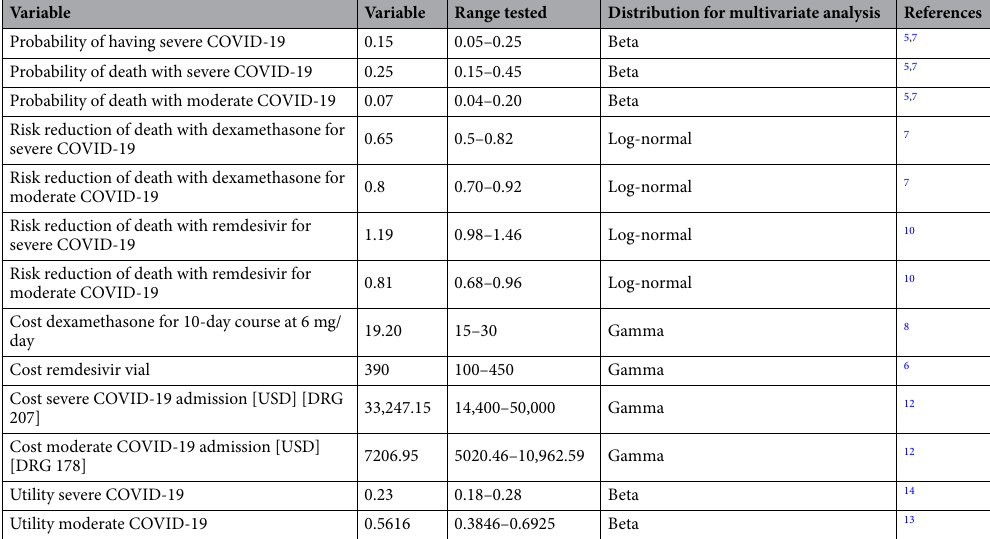
Table 1. Model inputs.